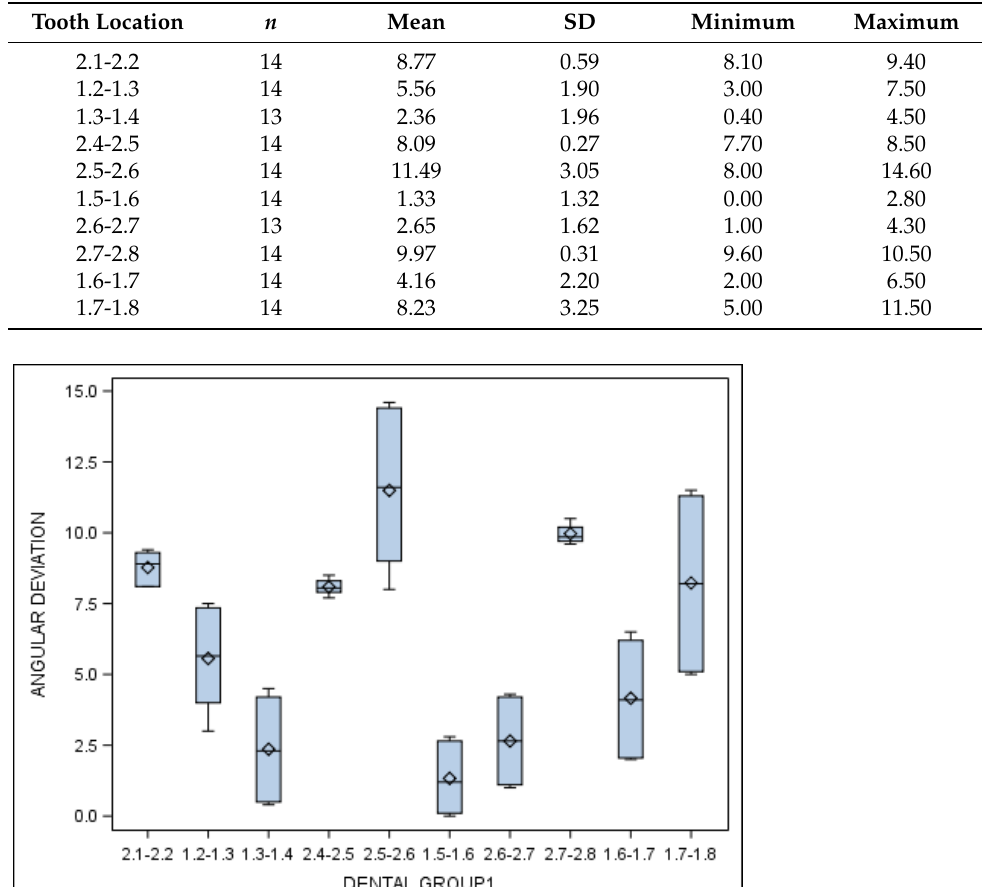
Figure 12. Box plot of the angular deviations of the orthodontic micro-screws in the selected tooth positioning. Twelve root perforations were observed in the conventional freehand technique